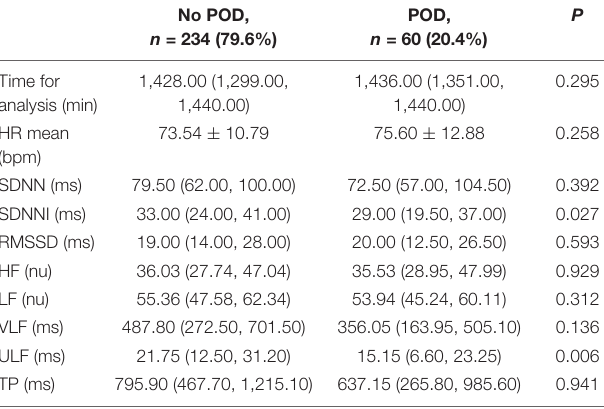
TABLE 1 | Descriptive characteristics of the cohort, stratified by POD. TABLE 2 | HRV parameters of the cohort, stratified by POD.